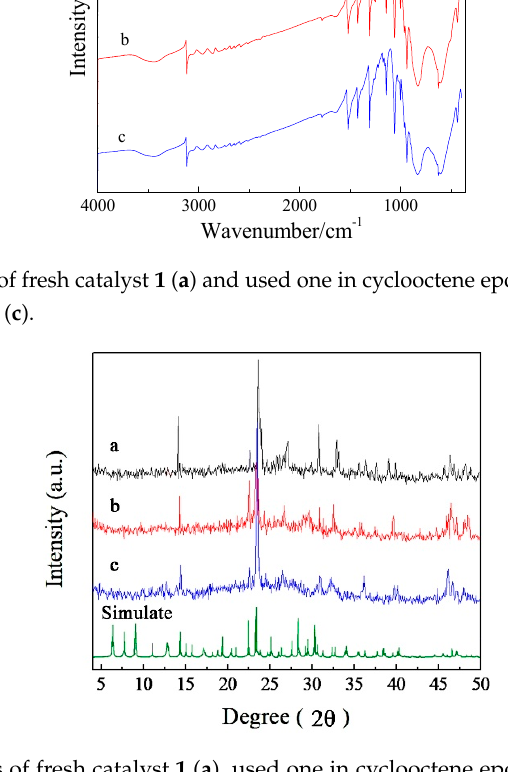
Figure 10. X-Ray photoelectron N1 spectra of catalyst 1 , Ag-trz 3 and trz. Figure 11. X-Ray photoelectron Mo3d spectra of PMA and catalyst 1 . In general, the polycatenane compounds have a relatively large open framework, which is suitable for the diffusion of the reactants to increase the substrate contact with the catalyst active sites, thus helping to improve the catalytic activity [31,42,44]. Meanwhile, the formation of multidimensional supramolecular structure through multiple weak interactions, such as charge interaction and hydrogen bonds, should be very critical in fabricating highly efficient and stable POM-based catalysts [12,42,45]. In our case, the relatively high stability of the catalysts 1 should be mainly due to the following reasons. First, the infinite three-dimensional polycatenated framework consisting of Ag + and 1,2,4-triazole ligand could effectively inhibit the aggregation of PMA clusters 392 394 396 398 400 402 404 406 408 410